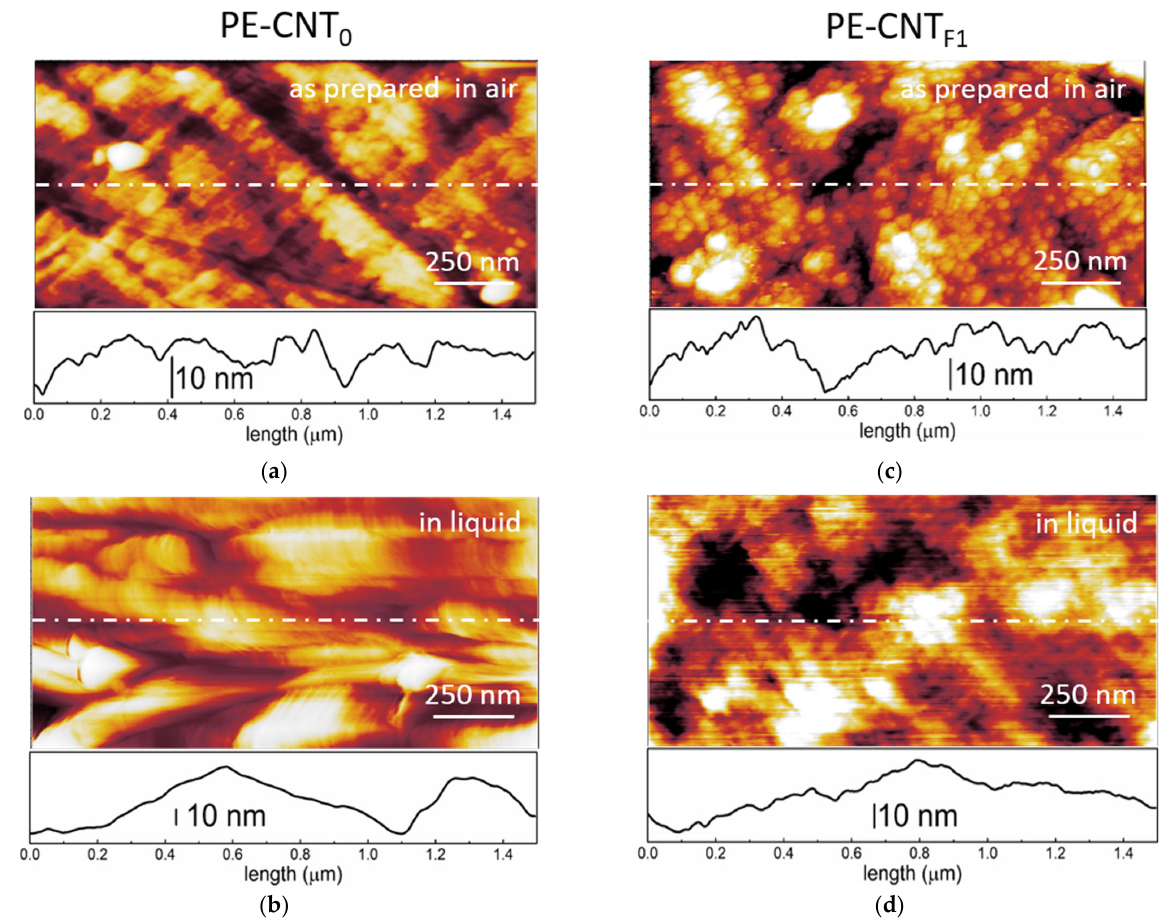
Figure 7. Surface morphology images [(1.50 × 0.75) μ m 2 ] of the CNTs ‐ based nanocomposites. ( a ) PE ‐ CNT 0 sample acquired as ‐ prepared and in air and ( b ) when the sample is immersed inside the electrolyte (H 2 SO 4 1 M) at the open circuit potential (OCP) (about 0.06 V vs. SHE). ( c ) PE ‐ CNT F1 sample acquired as prepared and in air and ( d ) when the sample is immersed inside the electrolyte (H 2 SO 4 1 M) at the OCP (about 0.04 V vs. SHE).